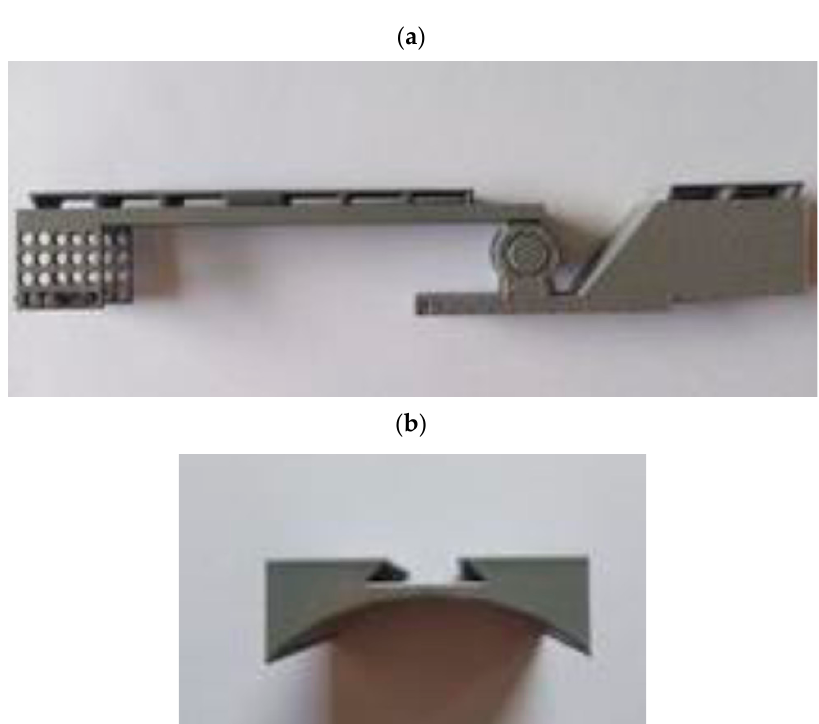
Figure 2. Parts of the exoskeleton for the elbow joint.